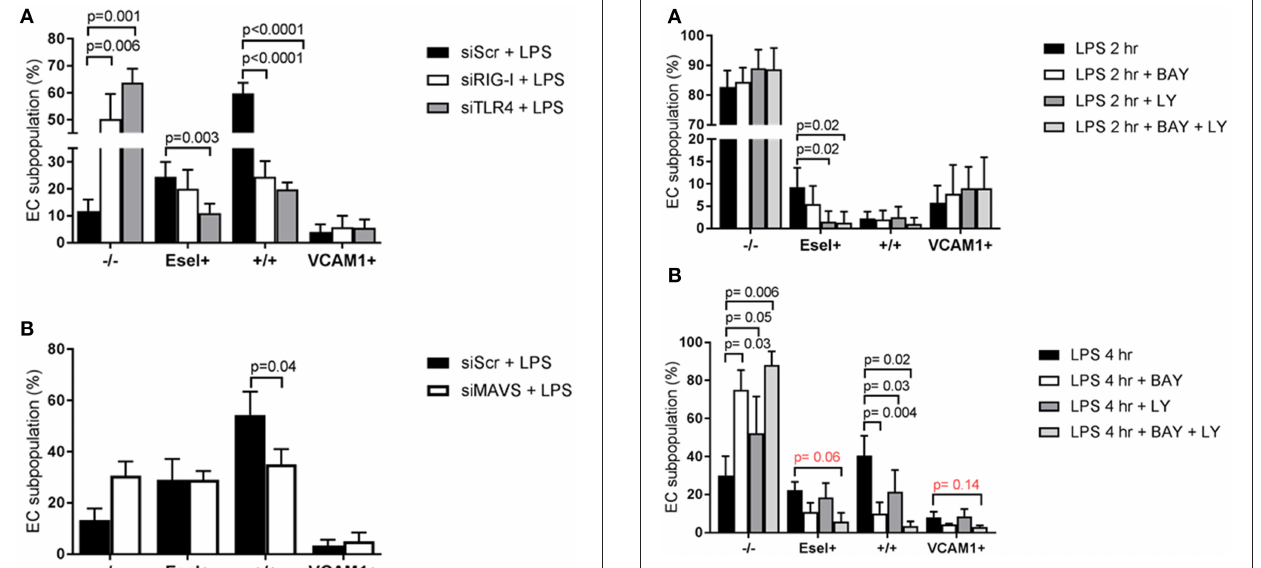
FIGURE 5 | TLR4 and RIG-I-MAVS differentially regulate LPS-mediated E-selectin/VCAM-1 subpopulation formation. (A) The effect of small interfering RNA (siRNA)-based RIG-I and TLR4 knockdown on the formation of LPS-induced EC subpopulations based on E-selectin and VCAM-1 expression after 4h of LPS exposure compared to scramble siRNA (siScr) controls. Bars represent the mean ± SD of 4 independent experiments. (B) The consequence of MAVS knockdown on the formation of the EC subpopulations. Bars represent the mean ± SD of 3 independent experiments. p < 0.05 is considered statistically significant.